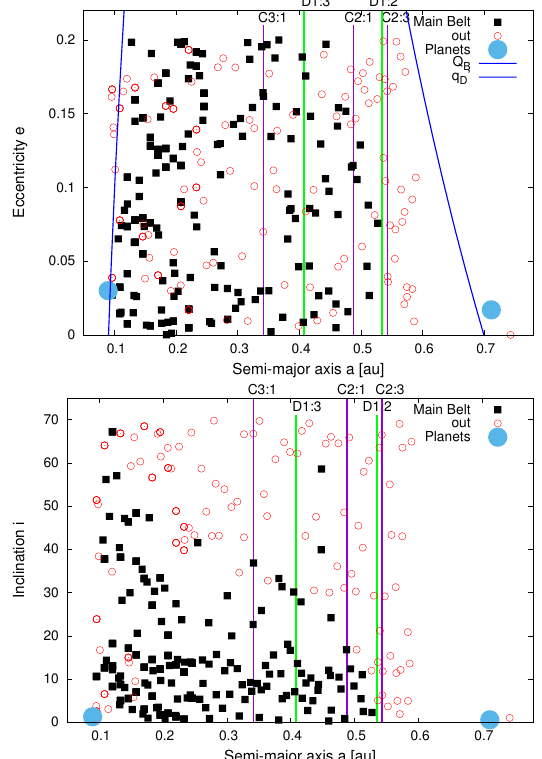
Figure 8. Luyten main asteroid belt (semi-proper elements) in the plane a − e plane ( top ) and a − i plane ( bottom ). Some of the asteroids will remain stable (squares) or eventually become non-stable (circle-dots). The vertical lines are the two main mean motion resonances with the planets Luyten D and Luyten